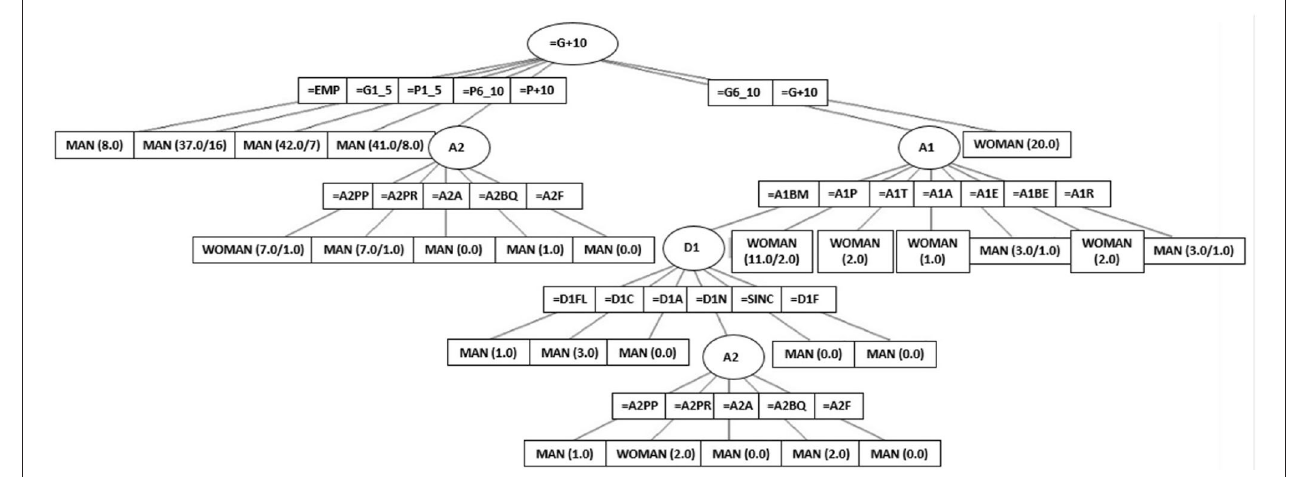
FIGURE 1 | Decision